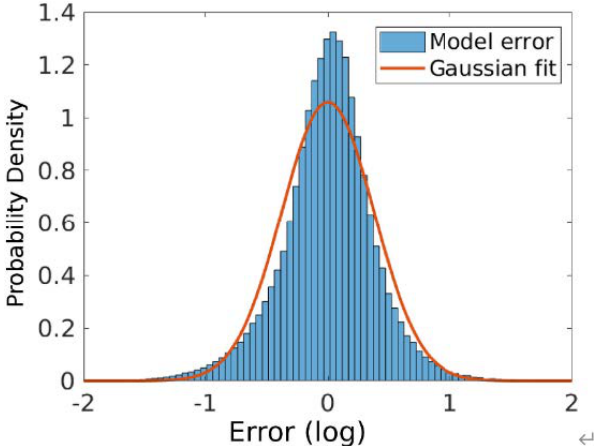
Fig. 6 Calibration of the calculation accuracy of the deterministic